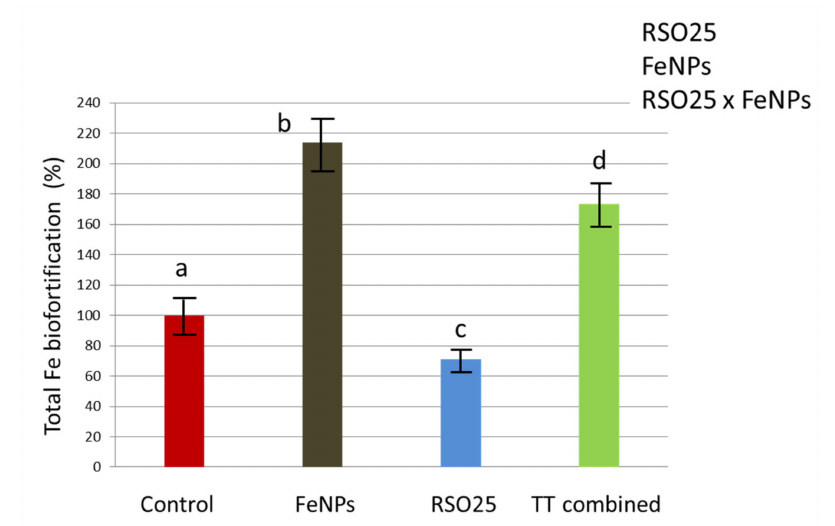
Figure 6. Net Fe biofortification per plant in Triticum aestivum treated with metallic Fe-containing polymeric nanoparticles (FeNPs), inoculated with Bacillus aryabhattai RSO25 (RSO25) and exposed to the combination of both treatments (TT Combined) for 45 days. Data are obtained after multiplication of the three parameters in Figure 5, i.e., the product of [spikes production] × [biomass of spikes] × [Fe accumulation in spikes]. RSO25, FeNPs or their interactions in the corner of the panel indicate main or interaction significant effects. Different letters indicate means that are significantly different from each other (LSD test, p <